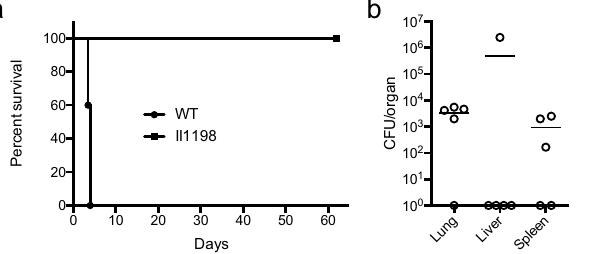
Figure 2. BP1026B_II1198 is attenuated in the BALB/c mouse model. ( a ) Mice infected with wildtype Bp 1026b (n = 5) did not survive beyond day four post challenge while mice infected with the BP1026B_II1198 mutant (n = 5) were able to survive for the duration of the study (62 days). Comparison of both experimental groups by Log-rank (Mantel-Cox) test shows a significant difference (P = 0.0031) in survival. Mice were challenged with a lethal dose (4500 CFU/mouse) via the intranasal route. ( b ) Lungs, livers, and spleens of the surviving mice were harvested, homogenized, and plated revealing persistent infection within the lungs of four mice, liver of one mouse, and spleen of three mice. No detectable bacteria were found in the lungs of one mouse, livers of four mice, and spleens of two mice (circles along x-axis).